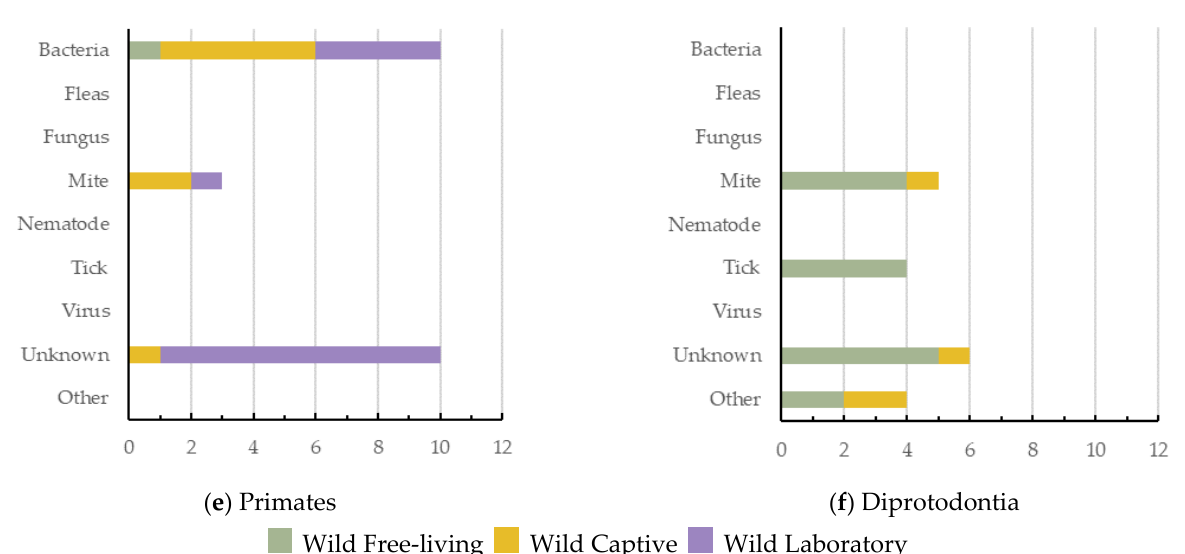
Figure 4. The causes of dermatitis diagnosed for each wildlife order, and for each captivity status (wild free-living, wild captive, and wild laboratory), plotted against the number of definitive dermatitis diagnosis/cases: ( a , c ) 0–25 cases; ( b , d – f ) 0–15 cases.